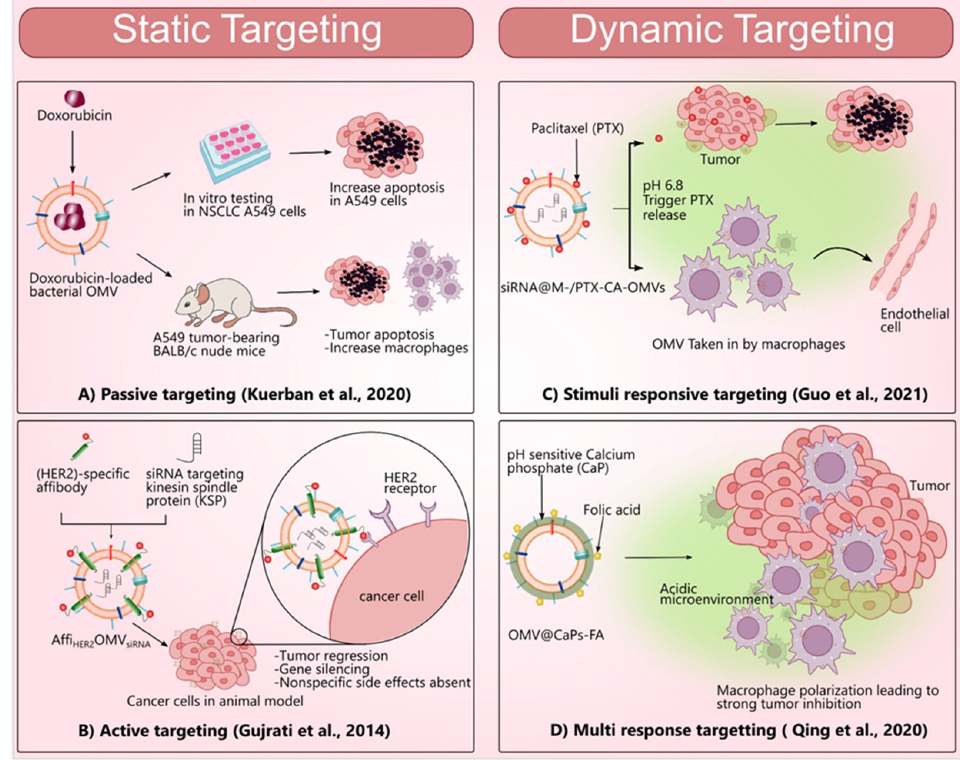
Figure 3. Static and dynamic targeting strategies of BMVs used as carrier systems [77,82,87,88].